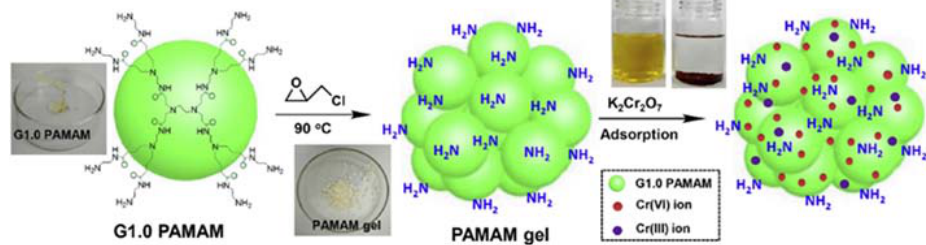
Figure 7. Schematic illustration of the preparation of amine-rich PAMAM gel from G1.0 PAMAM for removal of toxic Cr(VI) ions from water. Reprinted with permission from Ref. [86]. 2019, Elsevier.